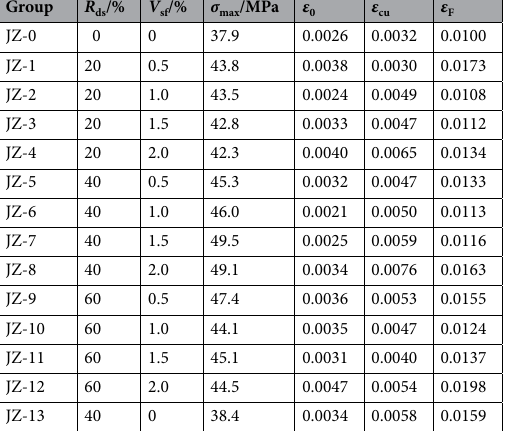
Table 4. Characteristic value statistics of the stress–strain curve. R ds means replacement rate of desert sand; V sf means volume content of steel fiber; σ max is peak stress; ε 0 is perk strain; ε cu is ultimate strain, take the value at 0.85 σ max in the descending section of the stress–strain curve; ε F is the strain when the specimen is